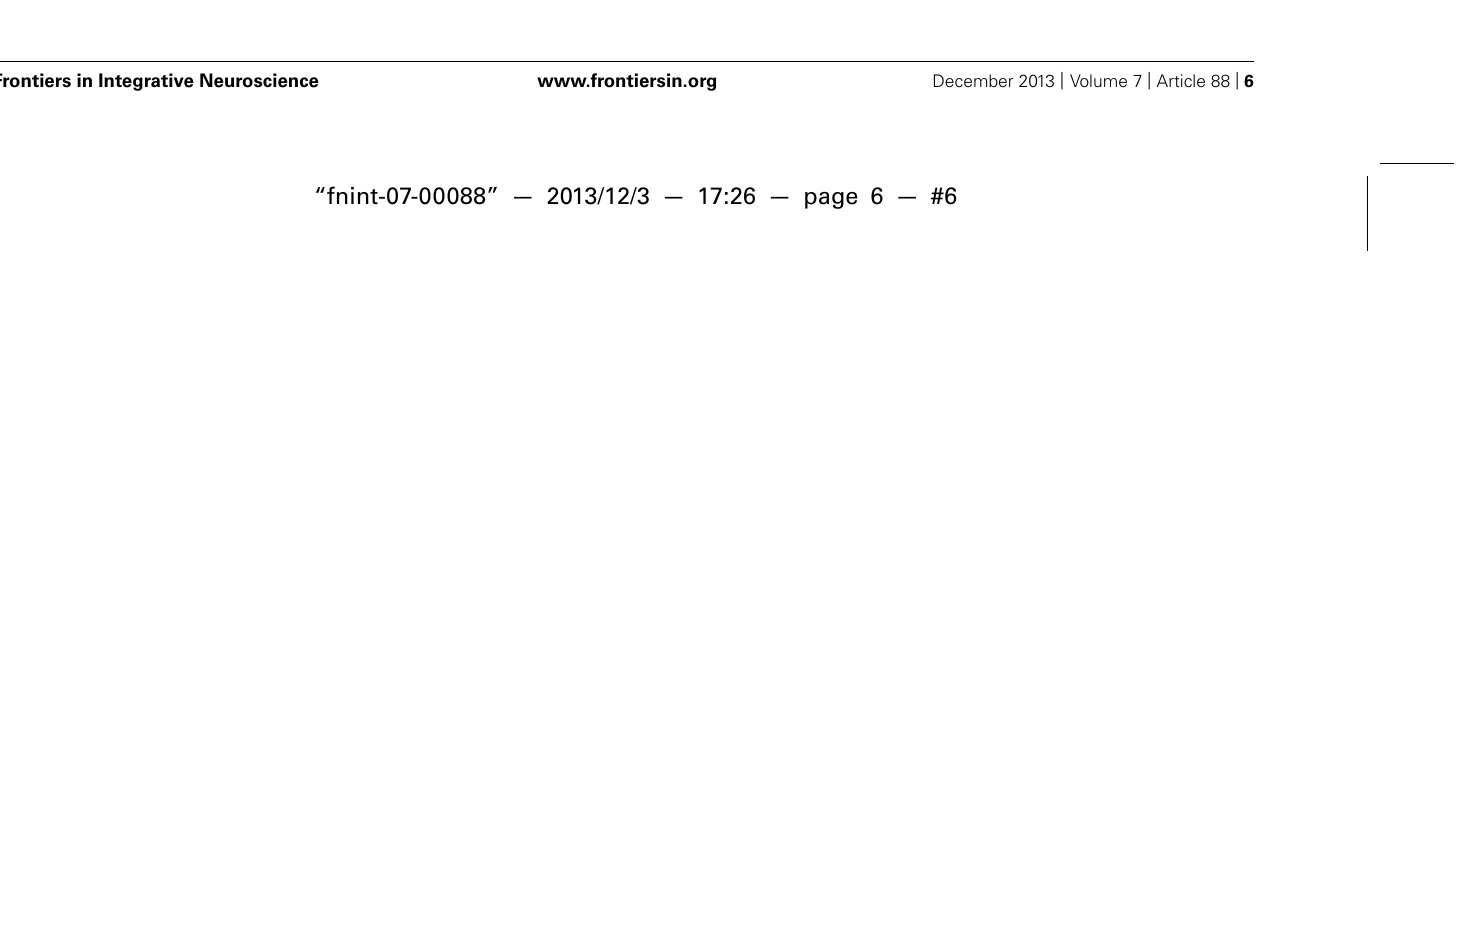
FIGURE 4 |Trial types of Experiment 2 – low uncertainty